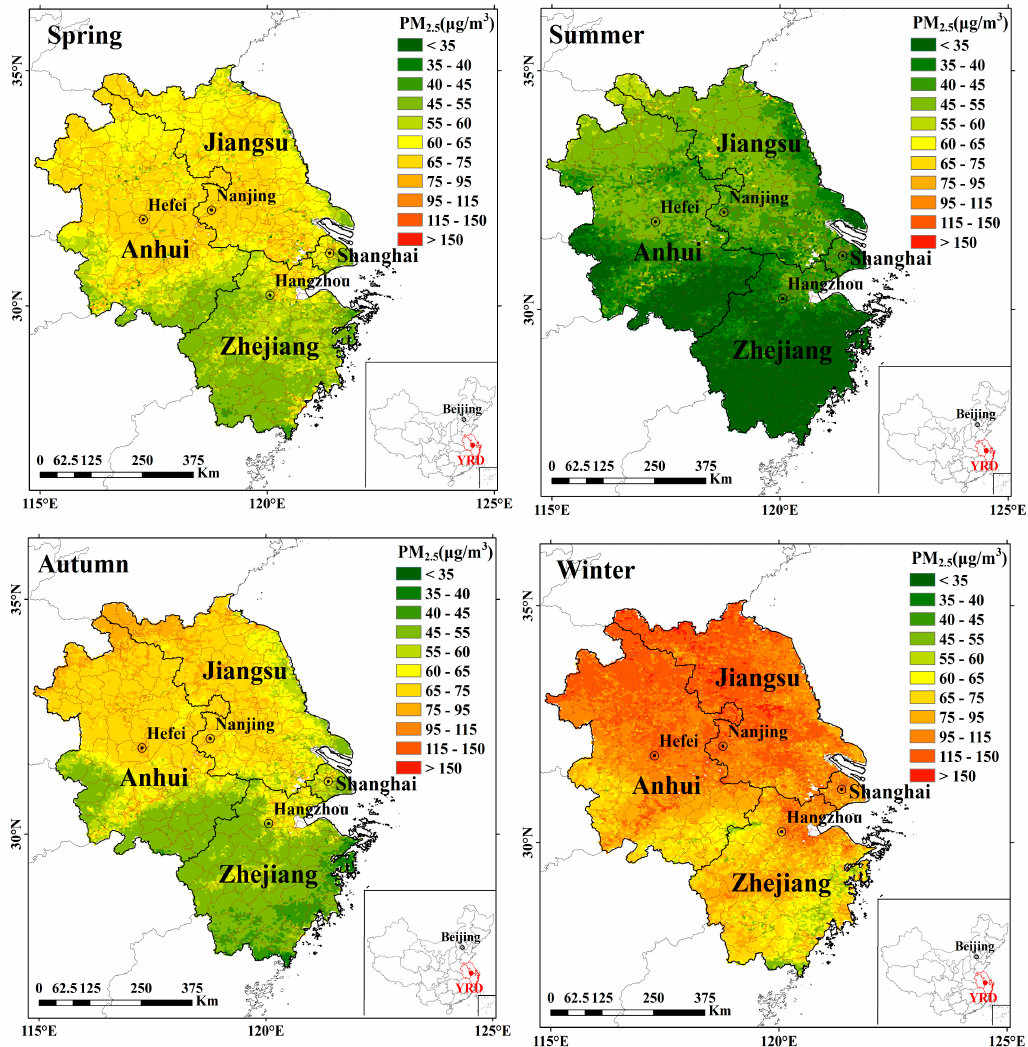
Figure 4. Seasonal spatial distribution of MODIS-based PM 2.5 concentration at 3-km resolution in the YRD Region in 2013.